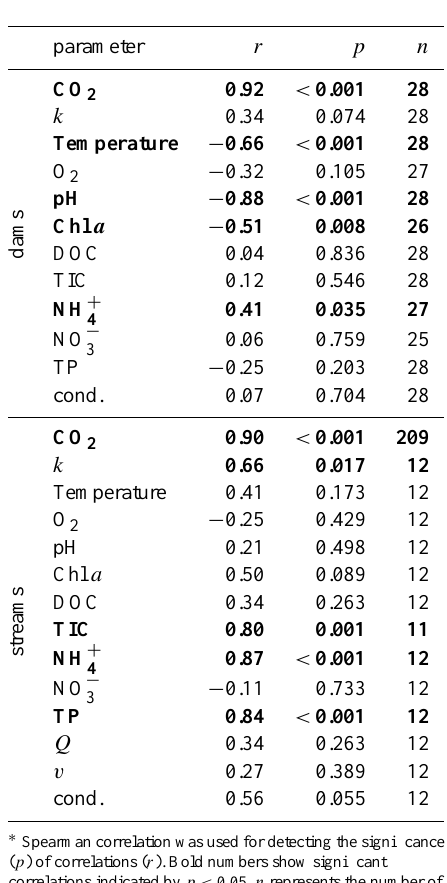
Table 2. Correlation of CO 2 evasion with different parameters, sorted for dams and streams.